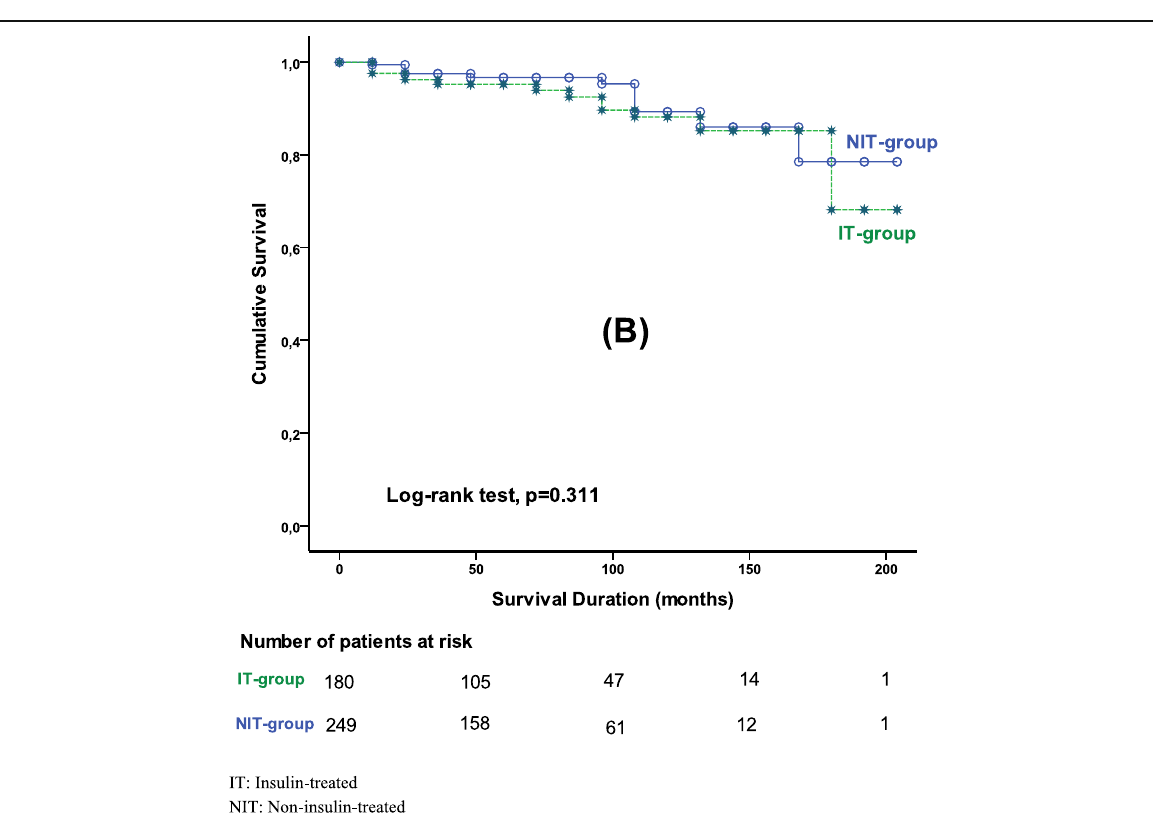
Fig. 2 Kaplan-Meier survival curve (B) for the whole cohort with all patients enrolled in the study with comparison between insulin-treated ( n = 322) and non-insulin-treated ( n = 207) patients. IT: insulin-treated, NIT: